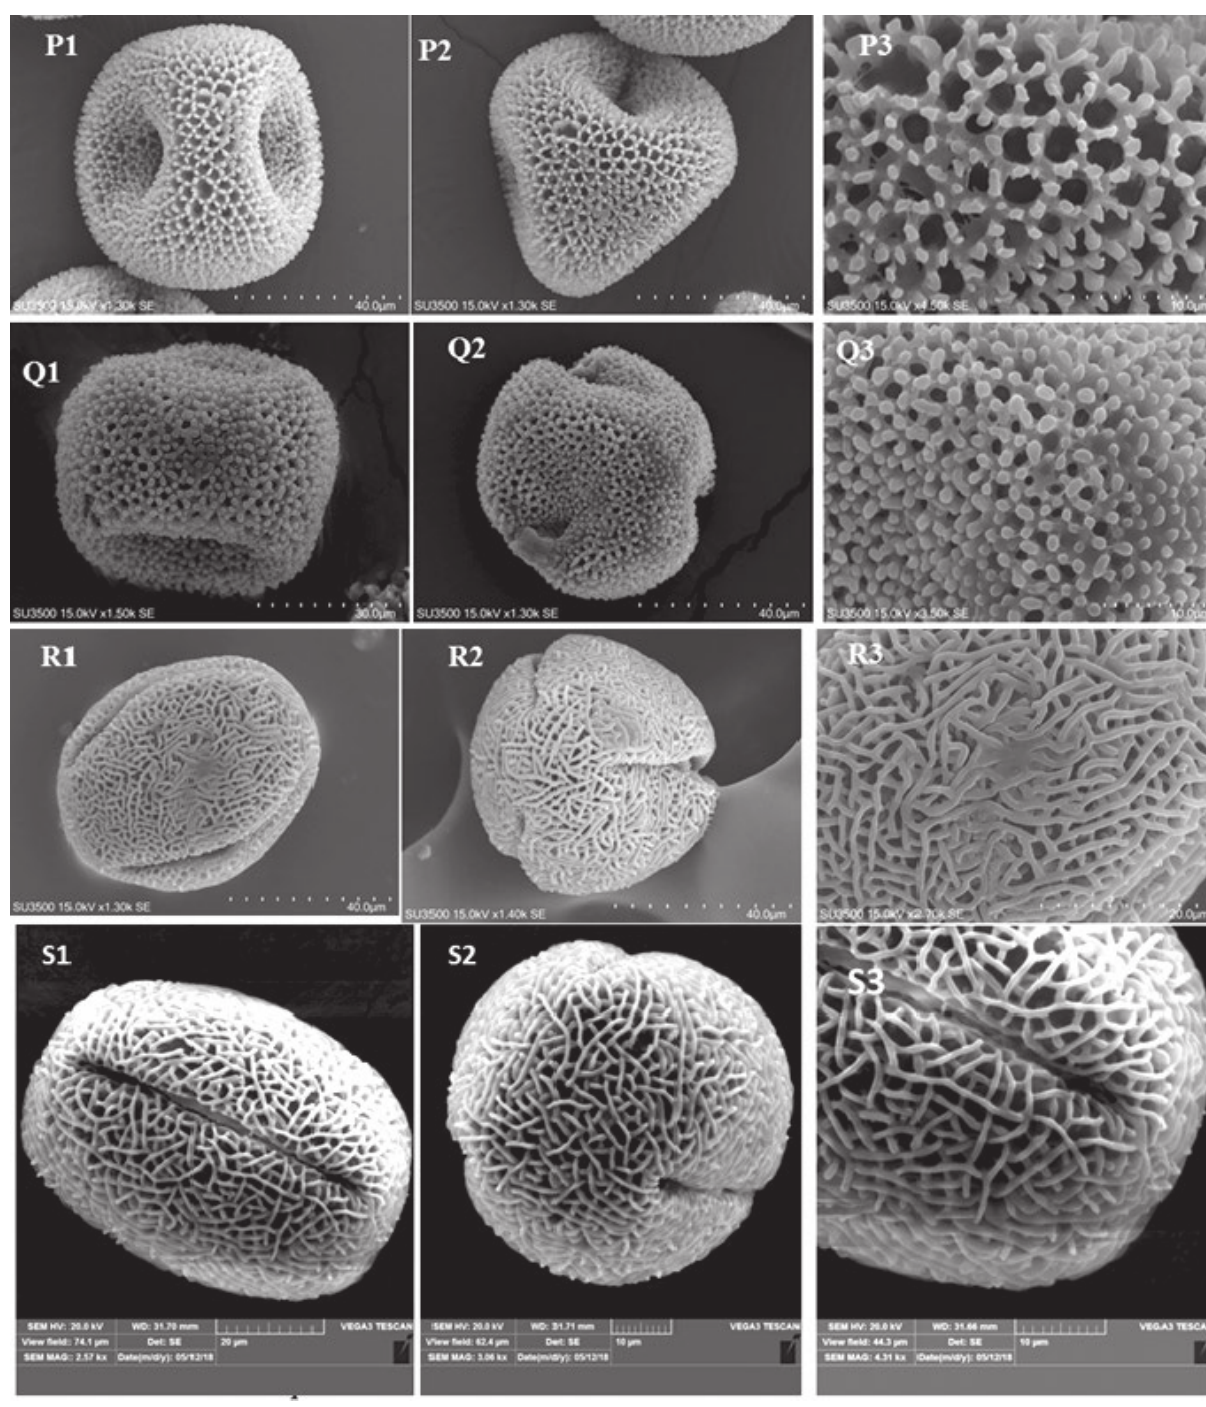
Figure 5. Pollen micrographs of Geranium species: P1-P3: G. robertianum , Q1-Q3: G. divaricatum , R1-R3: G. trilophum, S1-S3: G. mascat- ense; P1,Q1, R1, S1 – equatorial view; P2,Q2, R2, S2 - polar view; P3,Q3, R3, S3 -exine The discrepancy in the phylogenetic results obtained by lutionary relationships between Geranium, Erodium, and different molecular markers may be the reason for unre- are unclear because of the low support for the alternative solved species relationship in the genus Geranium . Evo- topologies inferred from both markers ( trnL–F and rbcL )